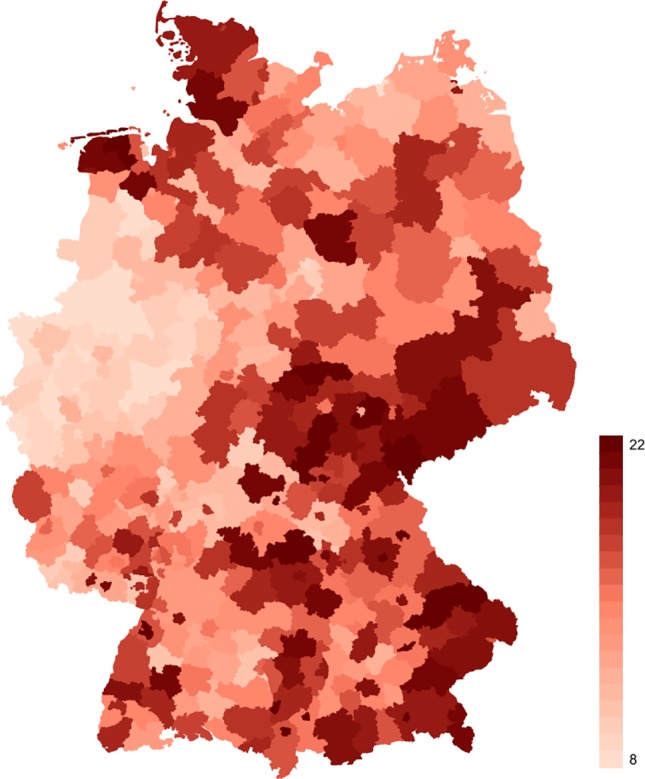
Observation period means of age- and gender-adjusted district suicide rates in Germany. The legend on the right hand side provides color codes for suicide rate values ranging from 8 (minimum) to 22 (maximum) per 100,000 inhabitants. Source: German Death Record, Area Population Numbers of Germany, 1997 to 2010, and 2013 European Standard Population - ed. by the German Federal Statistical Office (DESTATIS). Stata 15.0 was used to perform own calculations and create this figure.